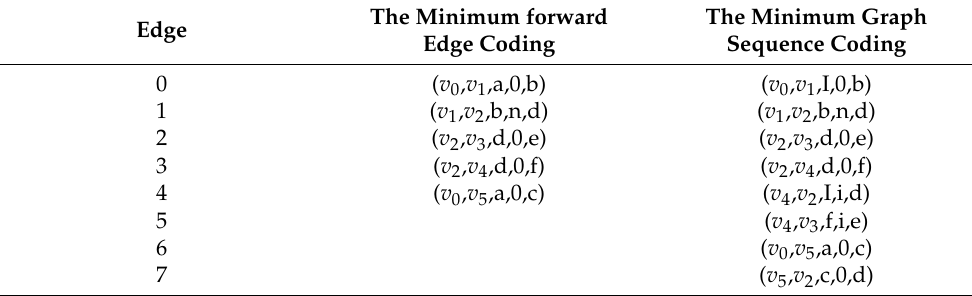
Table 2. Graph code